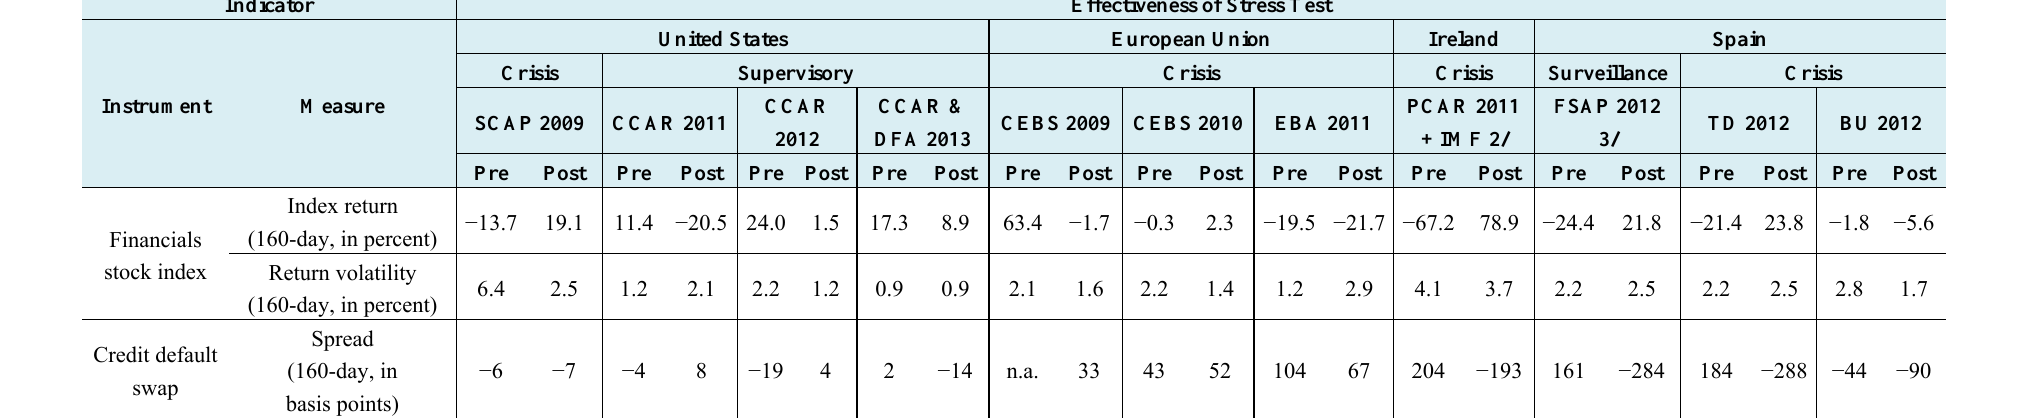
Table 3. Crisis (and Follow-up) Stress Tests: Performance Statistics